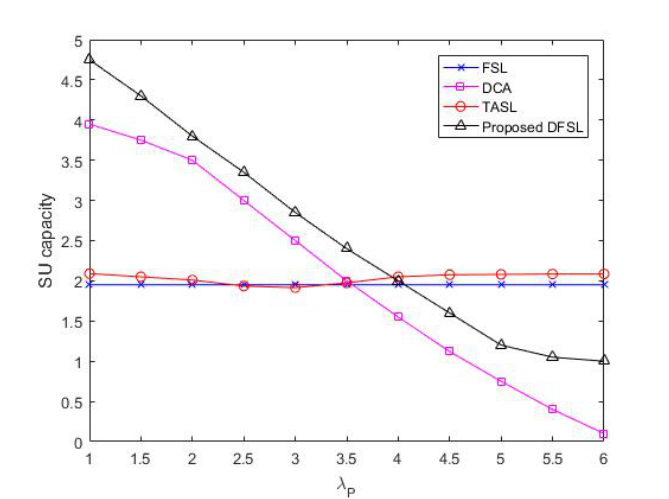
Figure 8. SU network capacity versus λ P